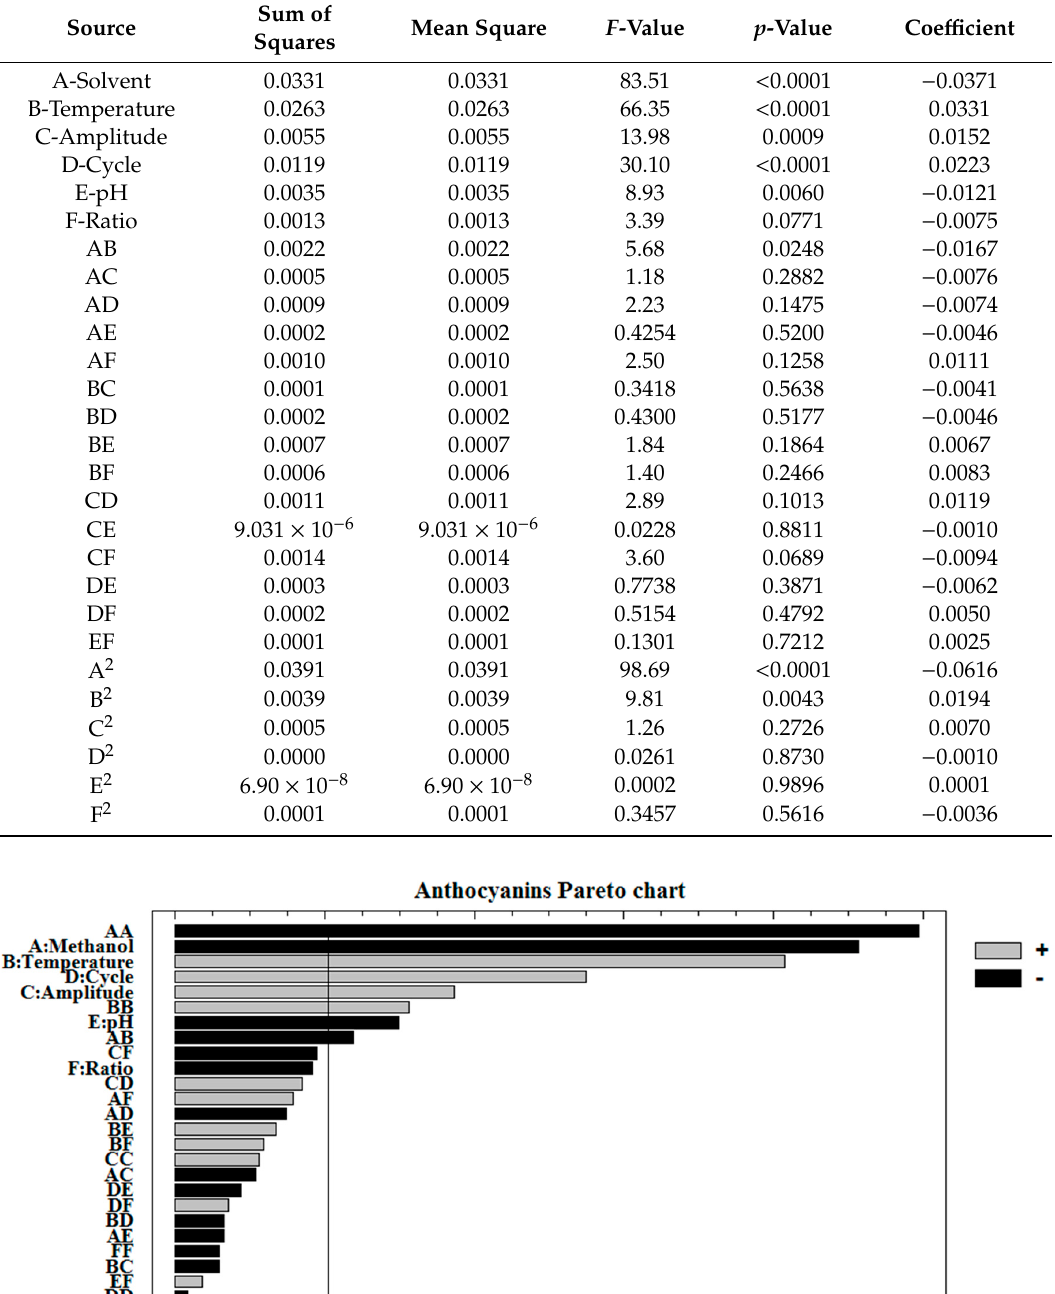
Table 2. Analysis of Variance (ANOVA) for the total anthocyanins quadratic model.